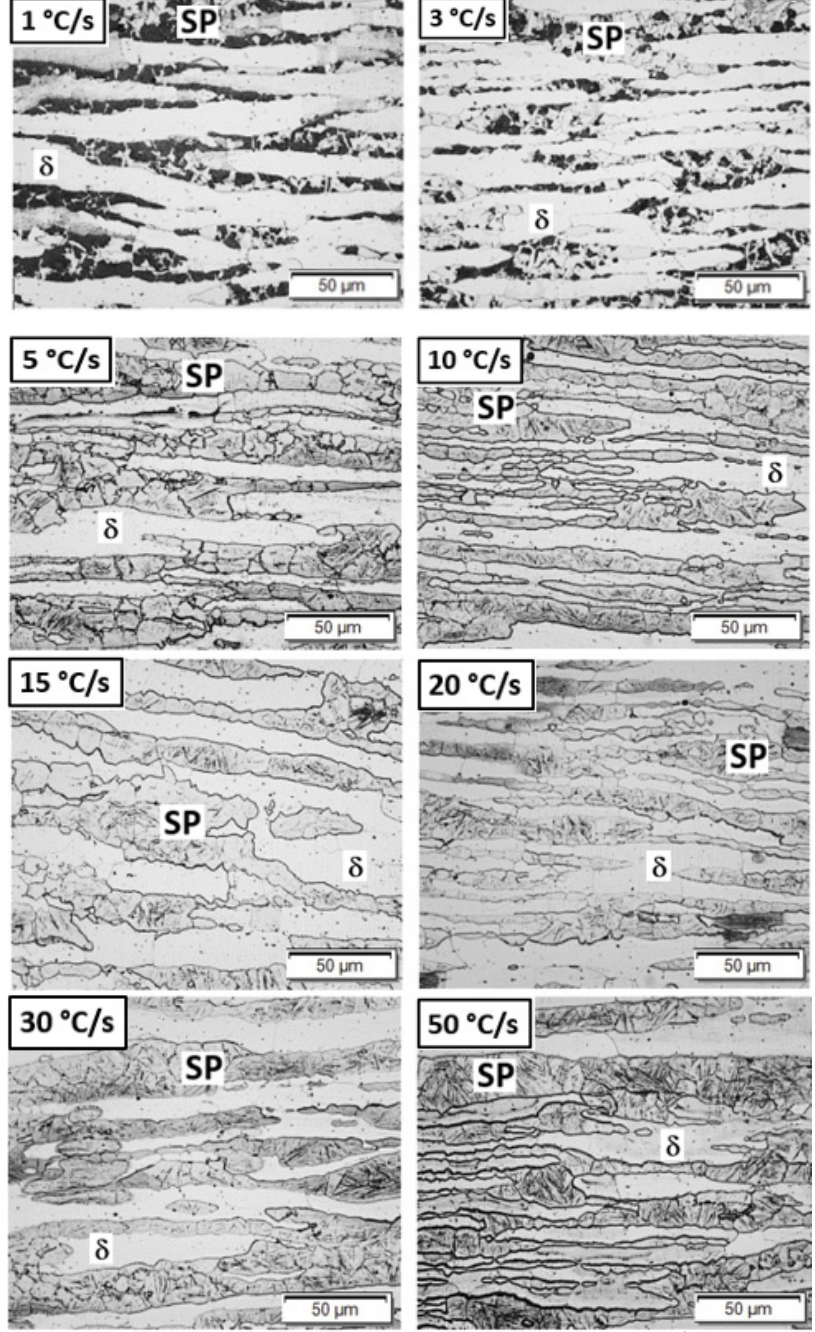
Figure 2. Optical microstructures resulting from the dilatometry tests under different continuous cooling rates ( δ = Ferritic matrix, SP = Second